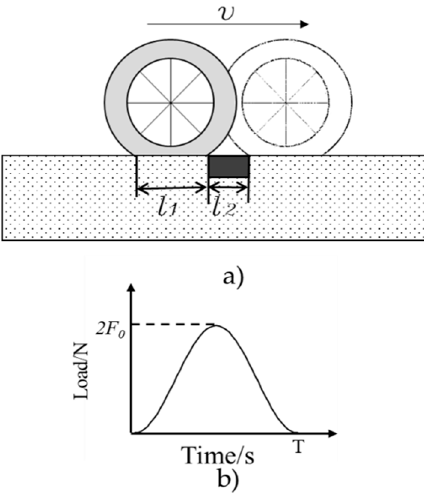
Figure 5. The simplified process of a vehicle loading on the embedded system. ( a ) wheel travelling along the pavement with a speed of v; ( b ) the equivalent semi-sine loading curve. Then, the loading frequency ( 𝑓 (cid:3039) ) caused by vehicle can be defined by Equation (11):